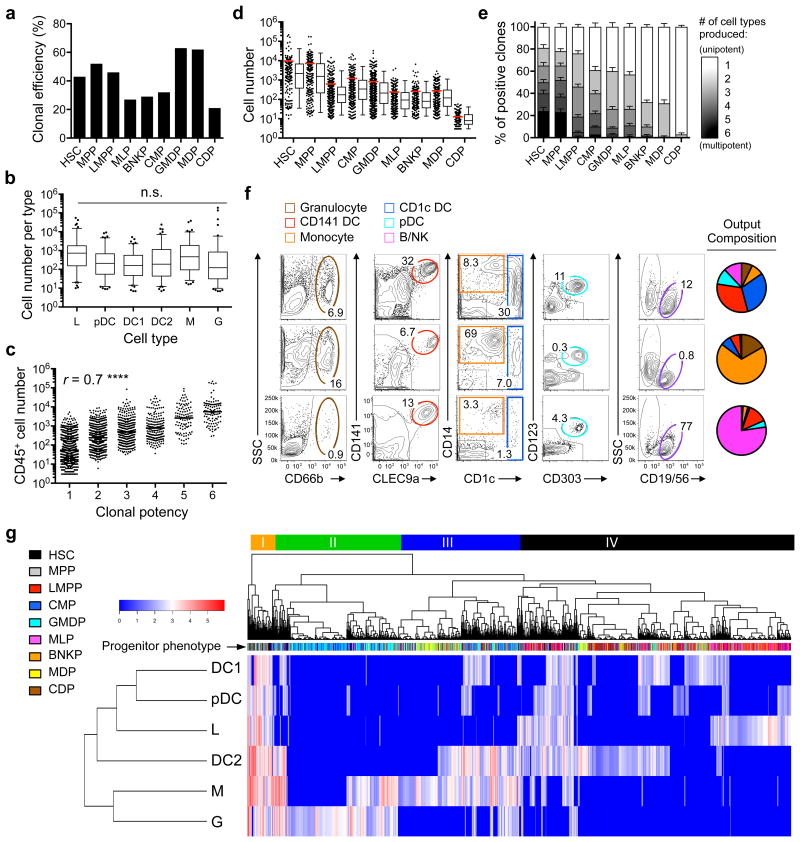
Clonal potency indicates heterogeneity of marker-pure progenitor populations and developmental distance from HSCs(a) Bar chart showing clonal efficiency for indicated populations after clonal culture in MP+FSG for 2-3 weeks. Clonal efficiency is defined as percentage of productive clones among total seeded wells for HSC (n=360), MPP (n=408), LMPP (n=791), MLP (n=720), BNKP (n=542), CMP (n=800), GMDP (n=890), MDP (n=357), and CDP (n=691). (b) Box-and-whisker plots (center line, median; lower and upper whiskers, 5% and 95% limit, respectively) showing yield of each cell type from all multipotent clones (n=105). (L): B/NK cells; (DC1): CD141+ DC; (DC2): CD1c+ DC; (M): monocyte; (G): granulocyte. Multiple unpaired two-tailed Student's t-test, n.s., not significant. (c) Scatter plots showing degree of correlation between clonal yield and potential. r, Spearman correlation factor; ****, p <0.0001. (d) Scatter plots and Box-and-whisker plots showing CD45+ cell yield of all clones in each population (red lines, mean). (e) Stacked columns summarizing qualitative potency of clones from each progenitor population. Bars are standard error of proportion of total positive clones. (f) Representative flow cytometry plots showing phenotype of live CD45+ cells produced from three individual multipotent clones. Pie charts showing relative abundance of cells for each corresponding clone. (g) Heat map showing normalized output for all six mature blood cell types (rows) from each single progenitor cell (columns). Colored bars on the top indicating four major clusters identified by unsupervised hierarchical clustering.